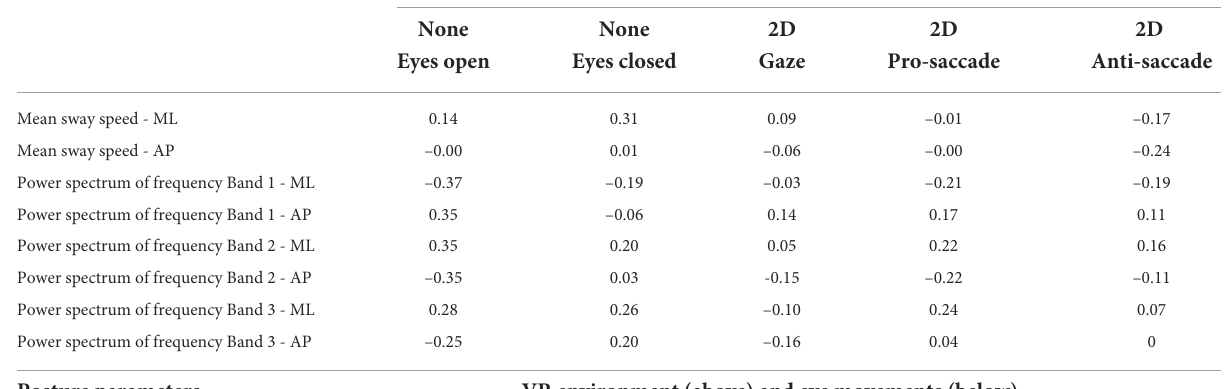
TABLE 4 Correlation coefficient between postural sway parameters and MoCA z-score (Thomann et al., 2018). Posture